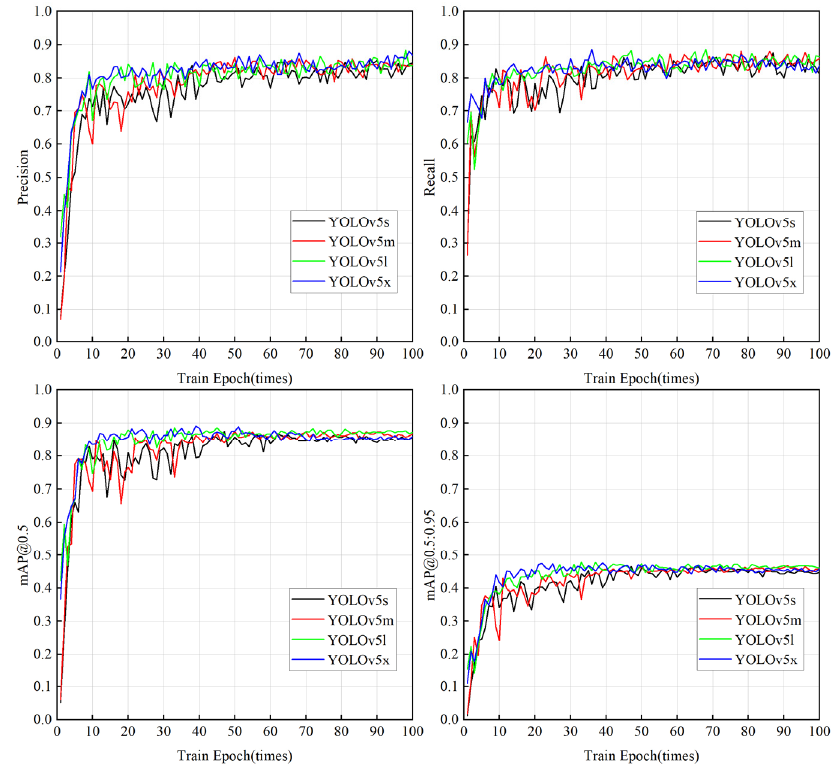
Figure 3. YOLOv5 training results.